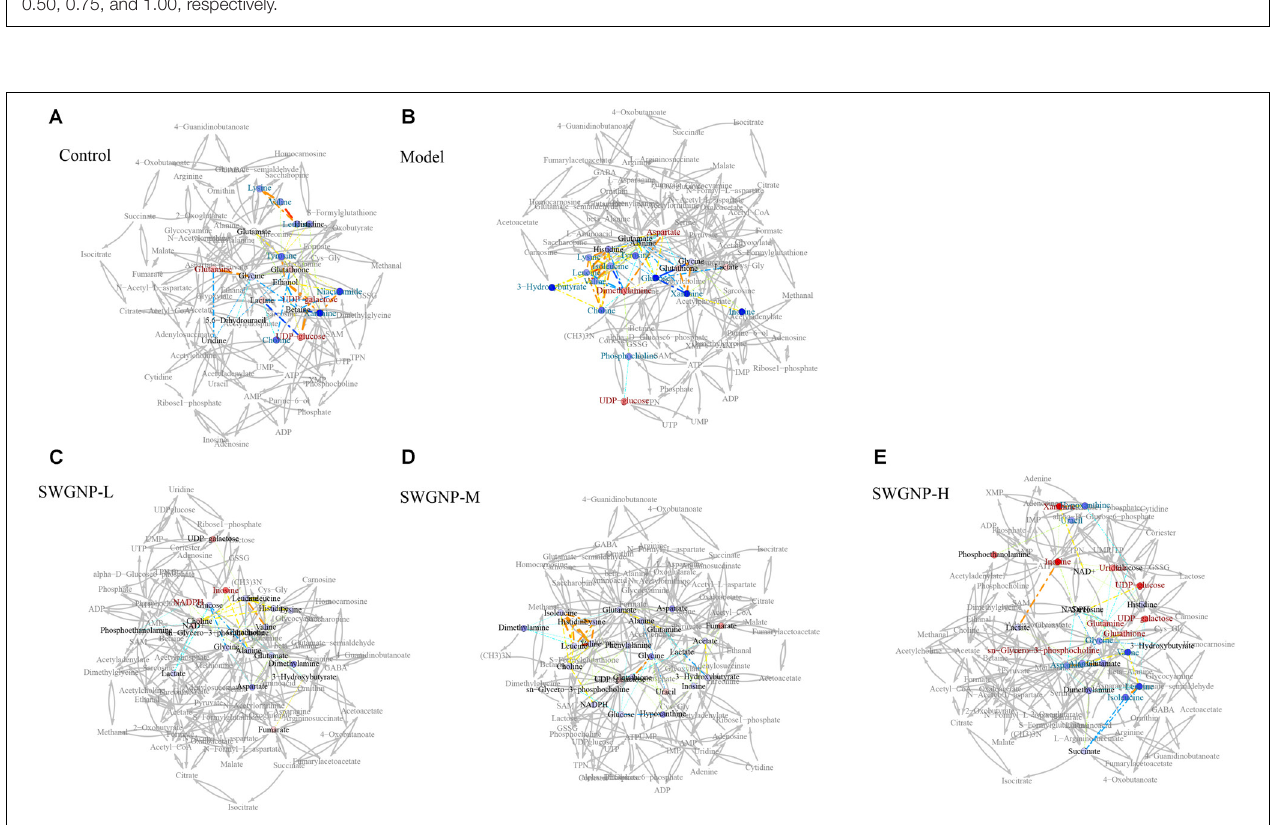
FIGURE 8 | Correlation network analysis of liver tissues. (A) Control: Normal control group; (B) Model: CCl 4 -induced liver fibrosis model group; (C) SWGNP-L: Low dose of SWGNP treatment group; (D) SWGNP-M: Medium dose of SWGNP treatment group; (E) SWGNP-H: High dose of SWGNP treatment group. NMR correlation was connected by dotted lines, colored according to Pearson correlation coefficient and auxiliary biochemical reaction by gray solid lines. Metabolites in red and blue represented significant increase or decrease. Circles were filled by the colors according to corresponding fold changes.